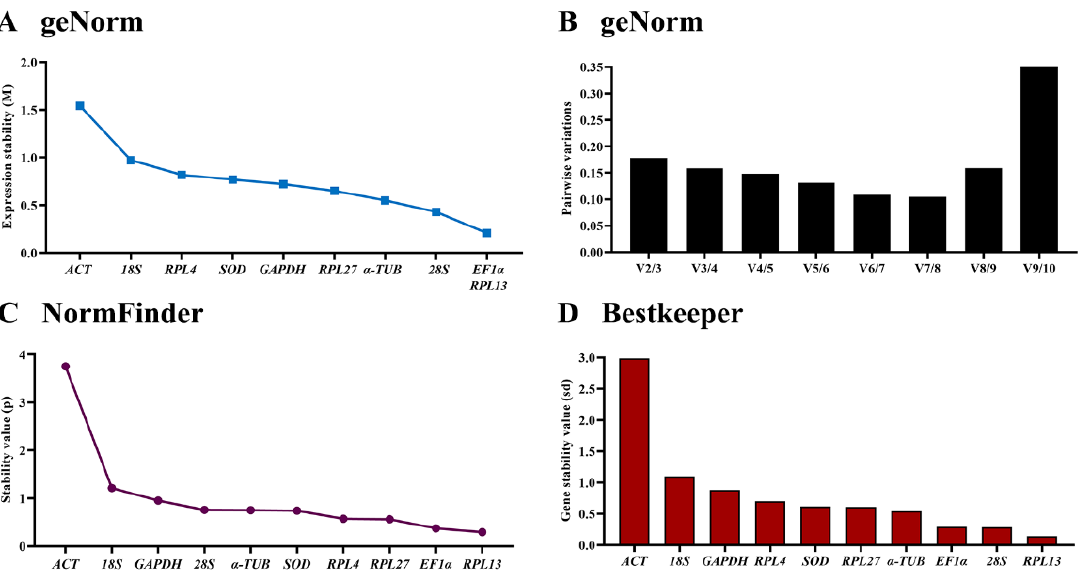
Figure 2. Expression stability of ten house-keeping genes during development stage in Phthorimaea operculella . All stages of P. operculella were sampled: young and old larvae, pupae and adults (collected on the first and second days of each stage). The expression stability rankings were determined by geNorm, NormFinder and BestKeeper.